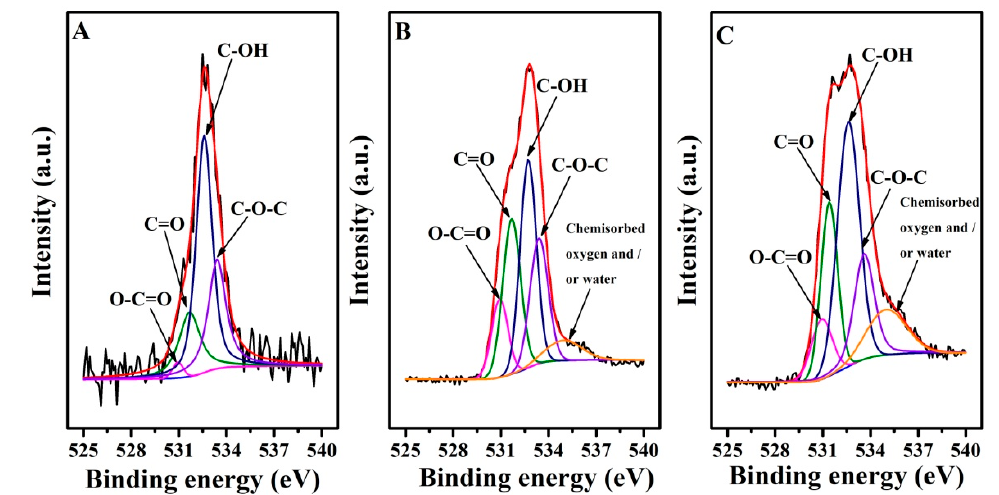
(cid:2876)(cid:2873)(cid:2906)(cid:2869) / (cid:2869) . (cid:2875)(cid:2873)(cid:2906) ( C ). ( C ). Figure 3. C1s spectra of GCE ( A ), EGO (cid:2870) / (cid:2879)(cid:2868) . 2/ − 0.85V